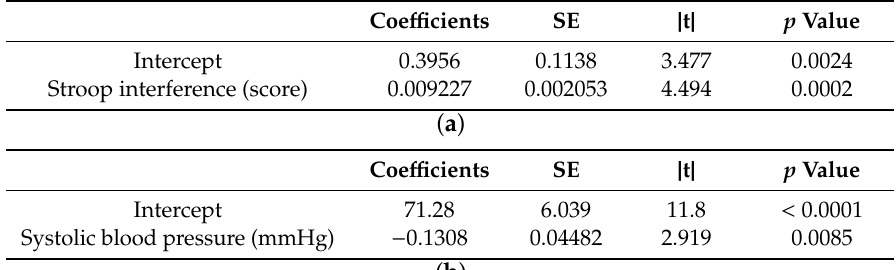
Table 4. Multiple linear regression model with postural balance by CoP ( a ) and BBS ( b ) in the COPD